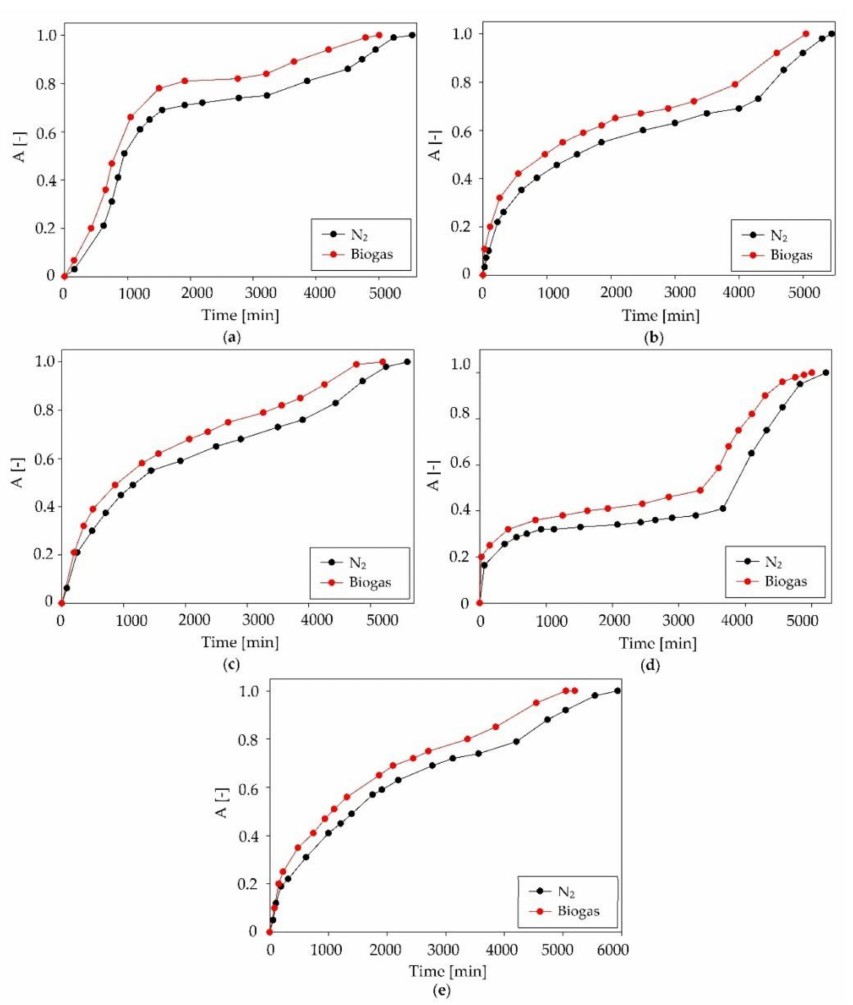
Figure 12. Absorption curves of C:DA (1:1) at various biogas matrix compositions for individual siloxanes: ( a ) L2, ( b ) L3, ( c ) L4, ( d ) D3 and ( e )